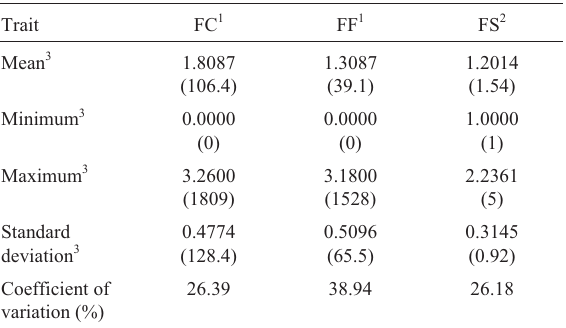
Figure 1 - Mean number of flies according to hair color (1= bay, 2 = or- ange, and 3 = red) and